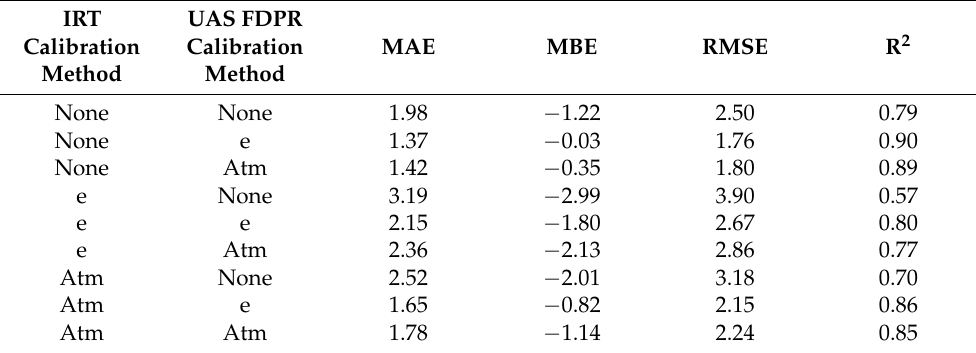
Table 4. Comparison results of measured surface temperature from UAS FDPR and field IRTs at different levels of